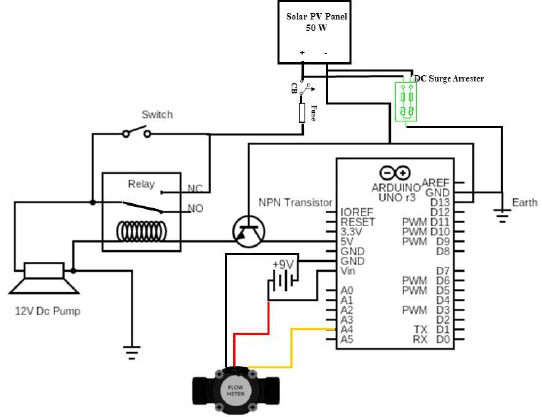
Figure 4. Electrical diagram of the system.